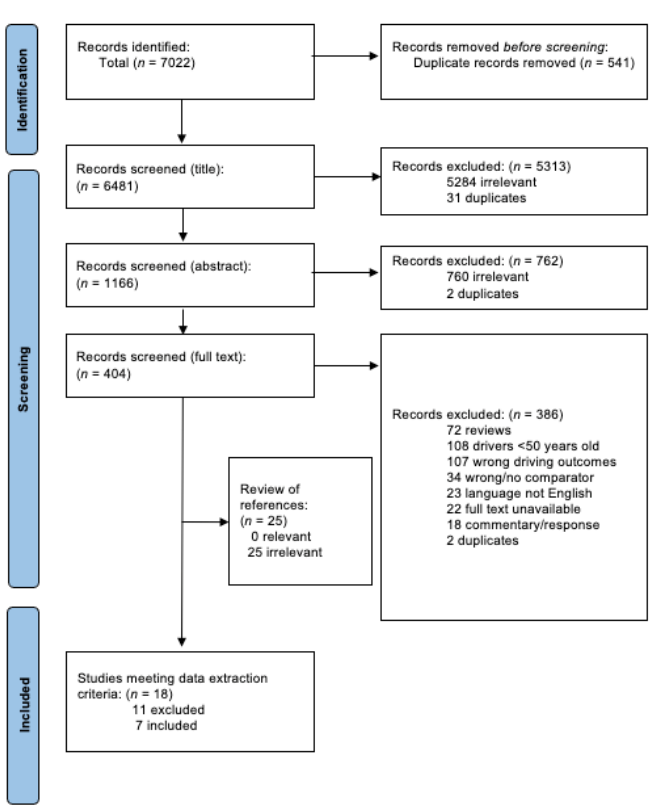
Figure 1. Flowchart of literature search and screening process using PRSIMA.